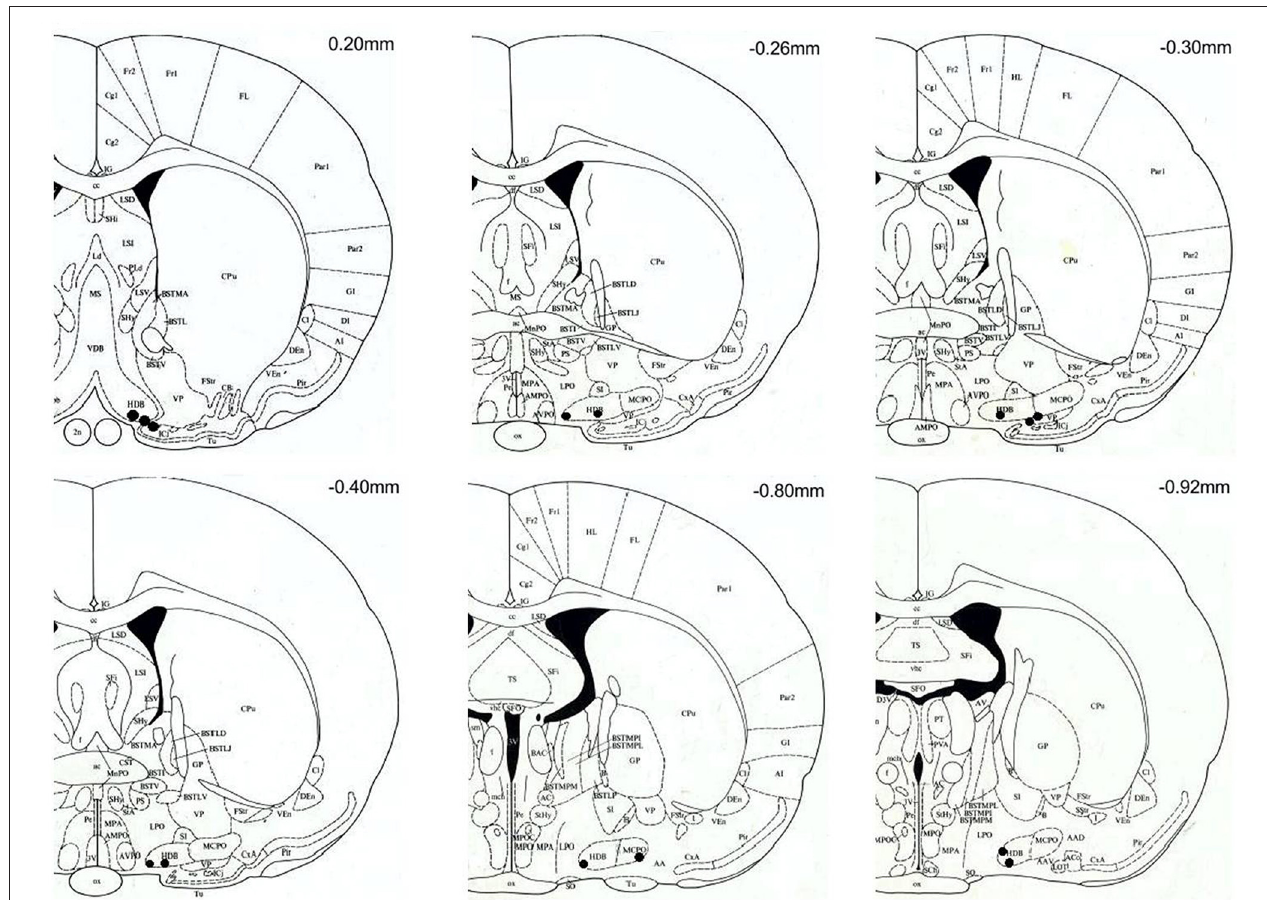
FIGURE 2 | Coronal brain sections (modified from Paxinos and Watson, 1998) with black spots marking the location of the microdialysis probe tips. All probe tips were located between anterior-posterior levels of + 20 and − 92 mm with respect to bregma. Target areas include: horizontal diagonal band of Broca (HDB), substantia innominata (SI), magnocellular preoptic area (MCPO), lateral preoptic area (LPO) and the basal nucleus of Meynert (B). The location of probes with tips outside the target area are not shown, and the corresponding rats ( n = 2, both on the ammonia-enriched diet) were excluded from the